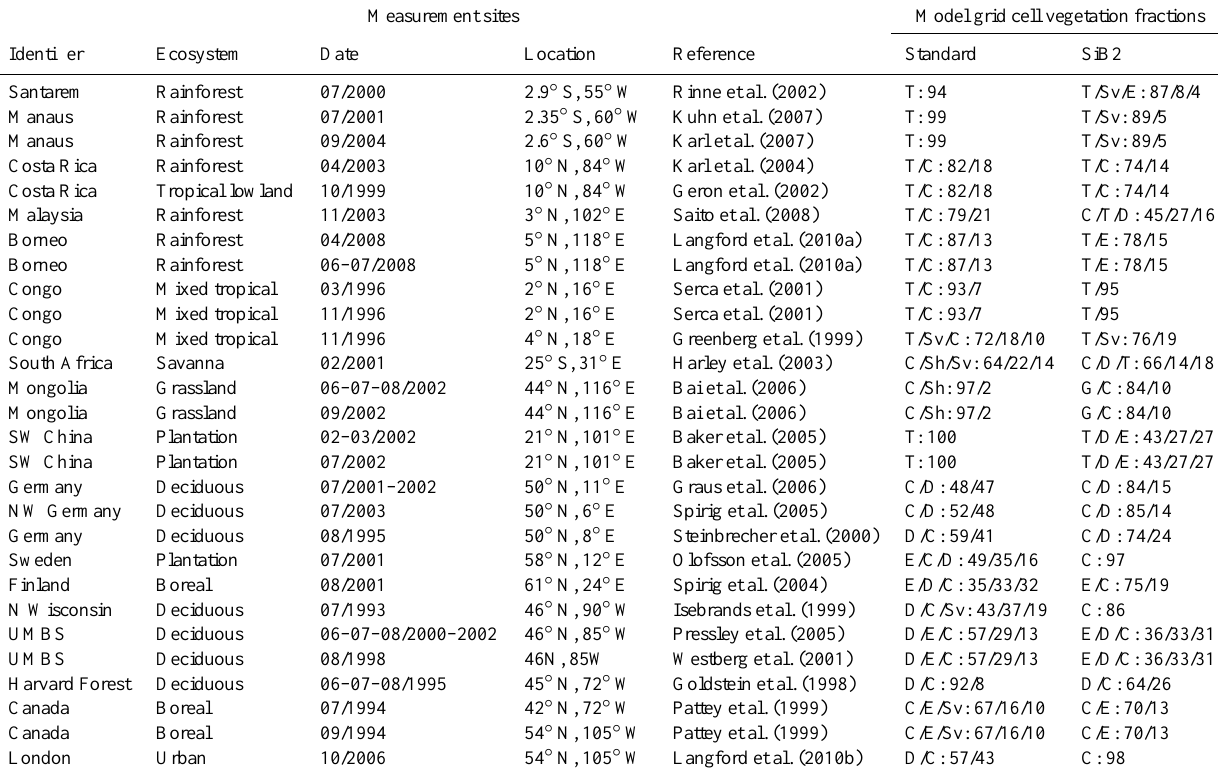
Table 4. Description of the 28 campaign-average above-canopy isoprene flux measurements collected between 1995–2010 across a wide range of ecosystem types, regions and seasons that comprise the benchmark global database. Codes for model vegetation fractions are: Td=tundra; G=grass; Sh=shrub; S=savanna; D=deciduous; T=tropical rainforest; E=evergreen; and